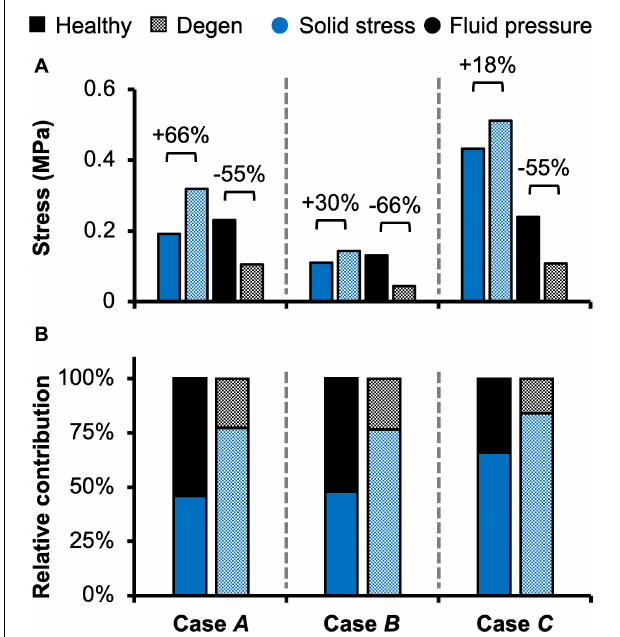
FIGURE 5 | Model-predicted (A) solid stress and fluid pressure, as well as (B) their relative contribution to the total stress taken by the disc in healthy and degenerated (Degen) models for Cases A , B , and C . Relative changes in solid stress or fluid pressure with degeneration are labeled above corresponding neighboring